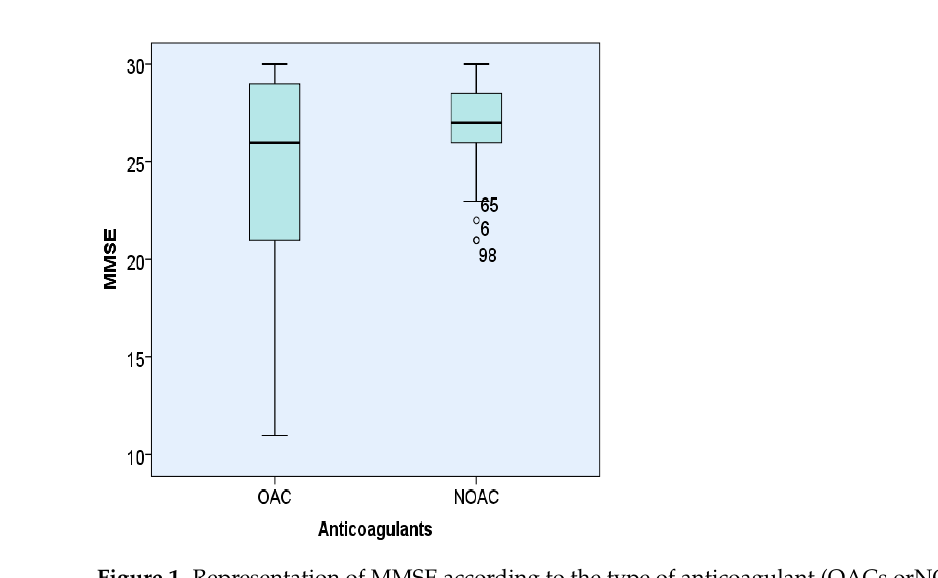
Figure 1. Representation of MMSE according to the type of anticoagulant (OACs orNOACs) used in hypertensive patients with AF.